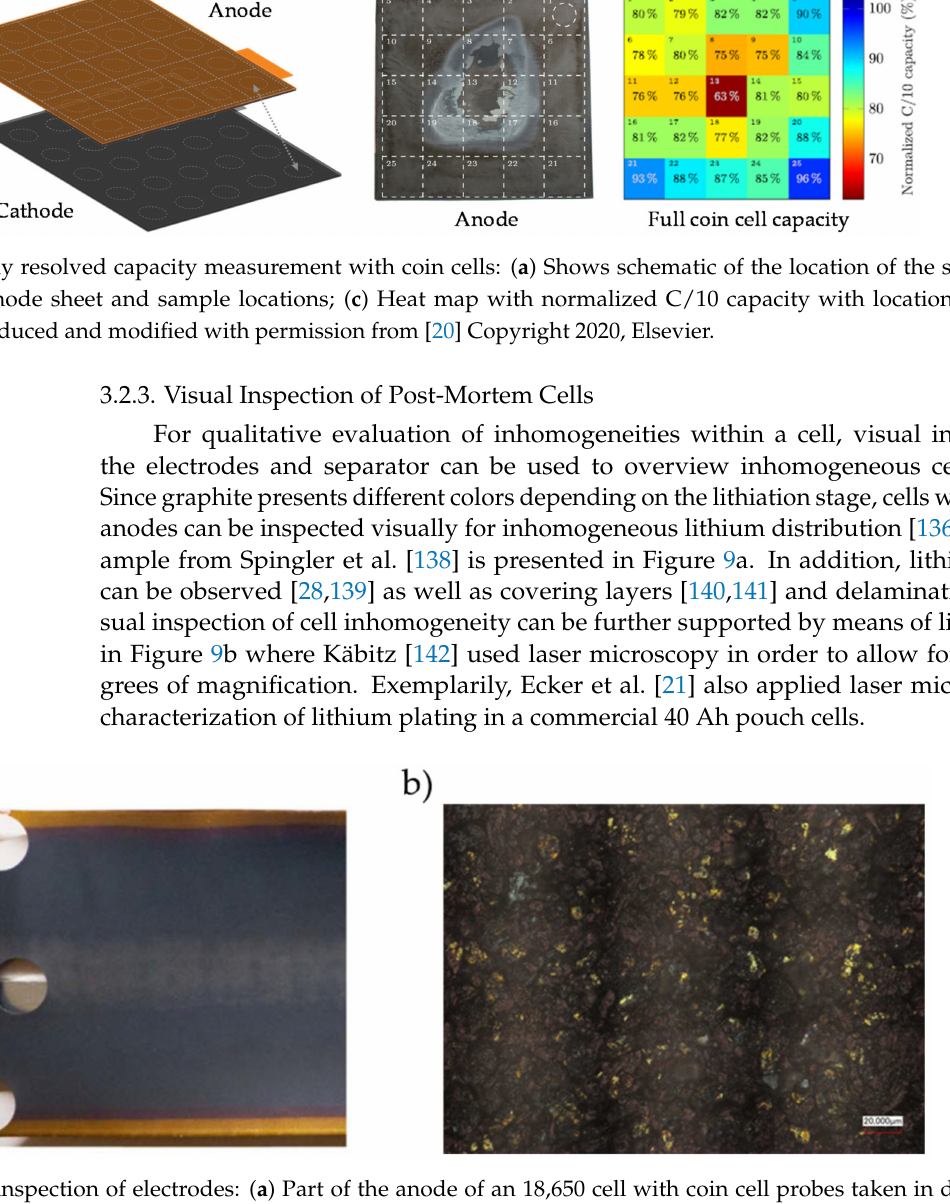
Figure 9. Visual inspection of electrodes: ( a ) Part of the anode of an 18,650 cell with coin cell probes taken in different locations of the cell. The outer part of the electrode shows a different lithiation than the middle part. (Modified from CC BY 4.0 by Spingler et al. [138]); ( b ) optical microscopy of the outer part of an anode showing individual particles with different lithiation (CC BY 4.0 by Käbitz